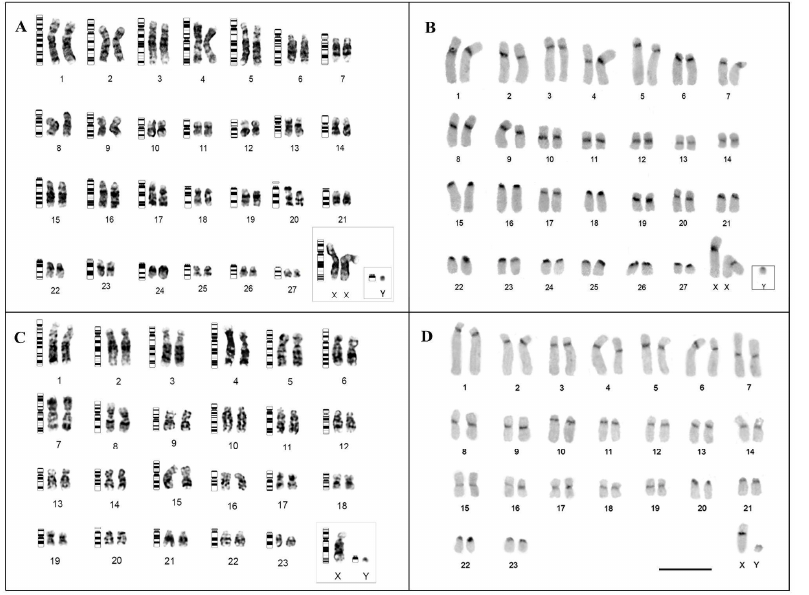
Figure 1. Karyotype of TIN ( A , B ) and TMM ( C , D ), after G-banding ( A , C ) and C-banding ( B , D ). In ( A , C ), an ideogram shows the pattern of G bands next to each chromosome pair. Bar 10 μ m.